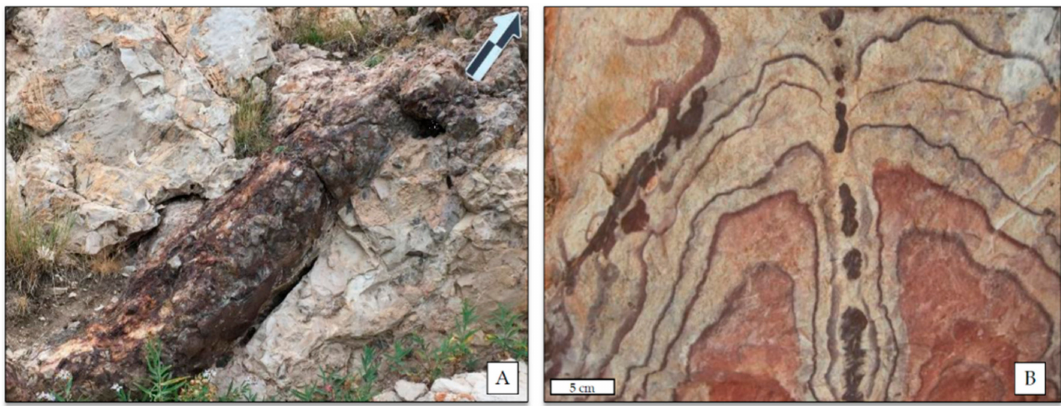
Figure 5. ( A ) Mineralized hematite- and limonite-stained, silicified THB cuts through bleached collapse paleokarst breccia along a fracture, Sandra mine area, PMD, 20 cm arrow for scale; ( B ) Liesegang banding developed in lower Amsden Formation adjacent to the Old Glory mine,